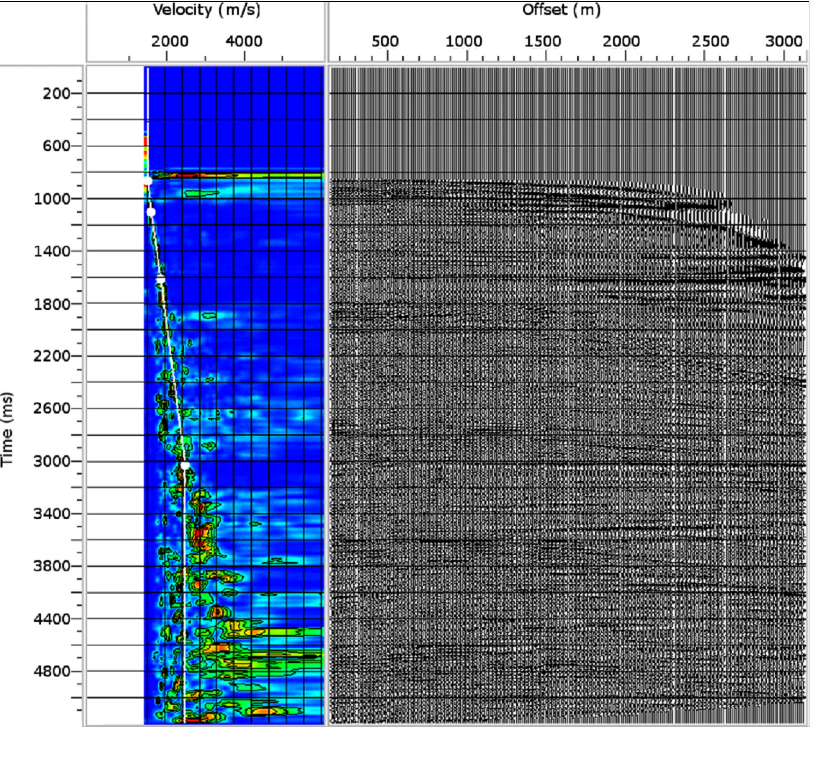
Figure 9. a) Stacked seismic section where the NMO velocity was estimated using conventional velocity analysis. b) Stacked seismic section where the NMO velocity was estimated using Al-Chalabi (1973) method. The blue rectangle show a region in detail where the frequency distortions due the NMO correction can be seen. The image using Al-Chalabi (1973) method is slightly more coherent than Figure 9a. In both images, the water-bottom multiples of first order, indicated by the red rectangle, are always